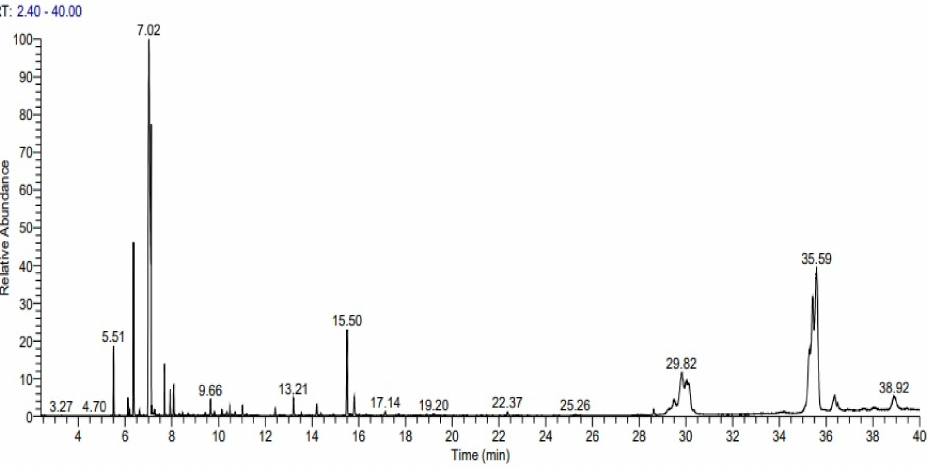
Figure 1. The GC-MS chromatograms of Citrus maxima essential oil